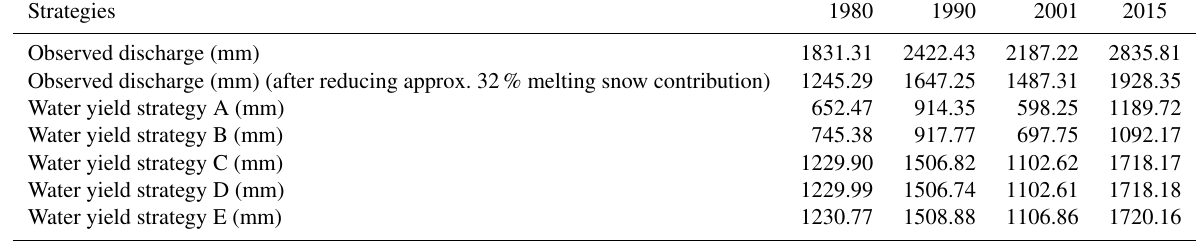
Table 3. Observed vs. computed water yield for various proposed strategies for Rishikesh sub-basin.